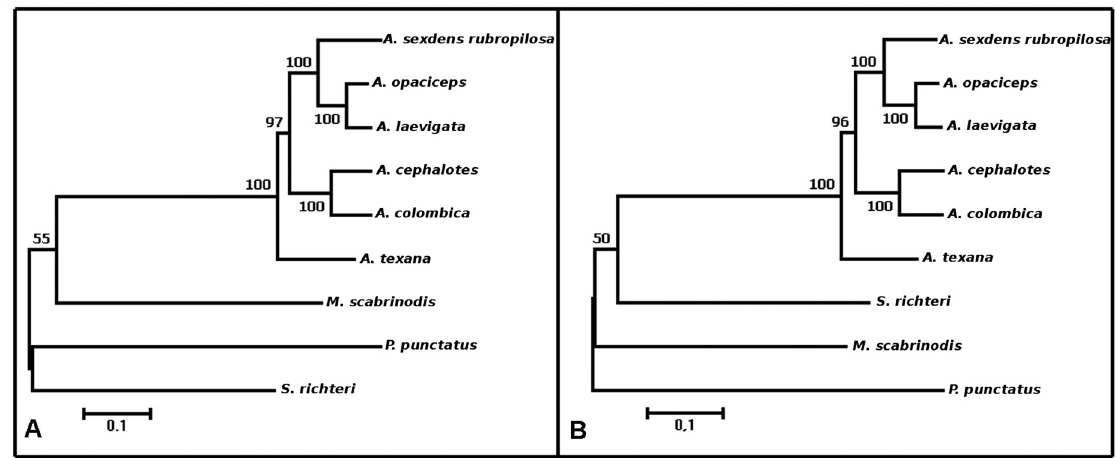
Figure 3 - (A) Molecular phylogenetic analysis by Maximum Likelihood method for complete mitogenomes and (B) for coding regions. In both A and B, the supported values were estimated by